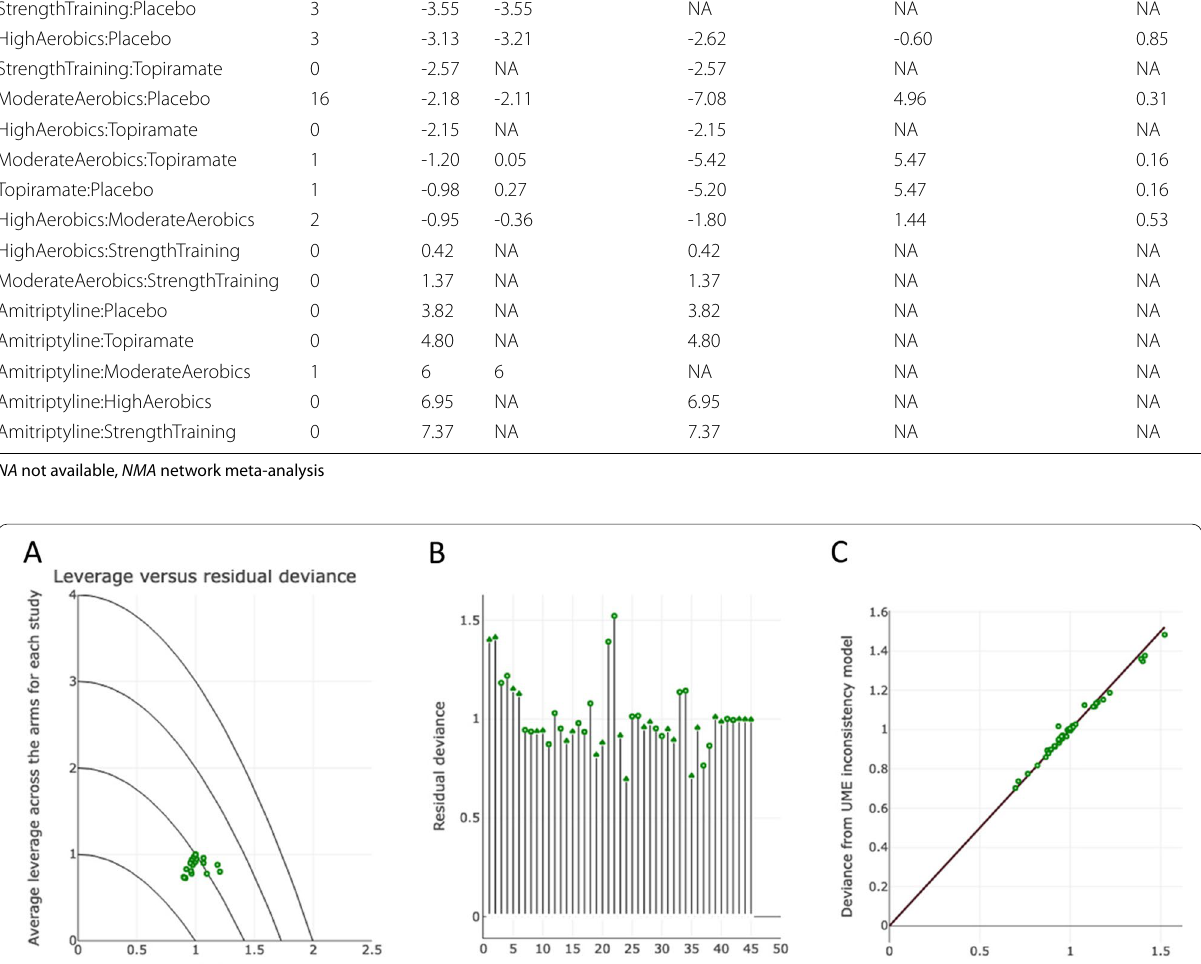
clinical outcomes, while anandamide was reduced after the intervention period and this change was significantly correlated with lower abortive medication use [13].